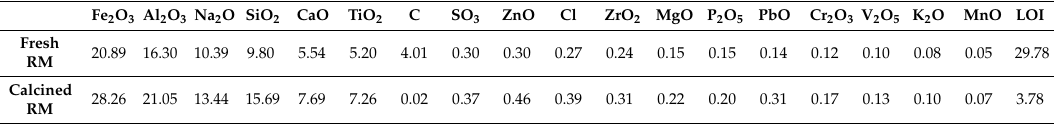
Table 1. ED-XRF chemical composition of the red muds before and after calcining (% by weight). Red mud (RM).